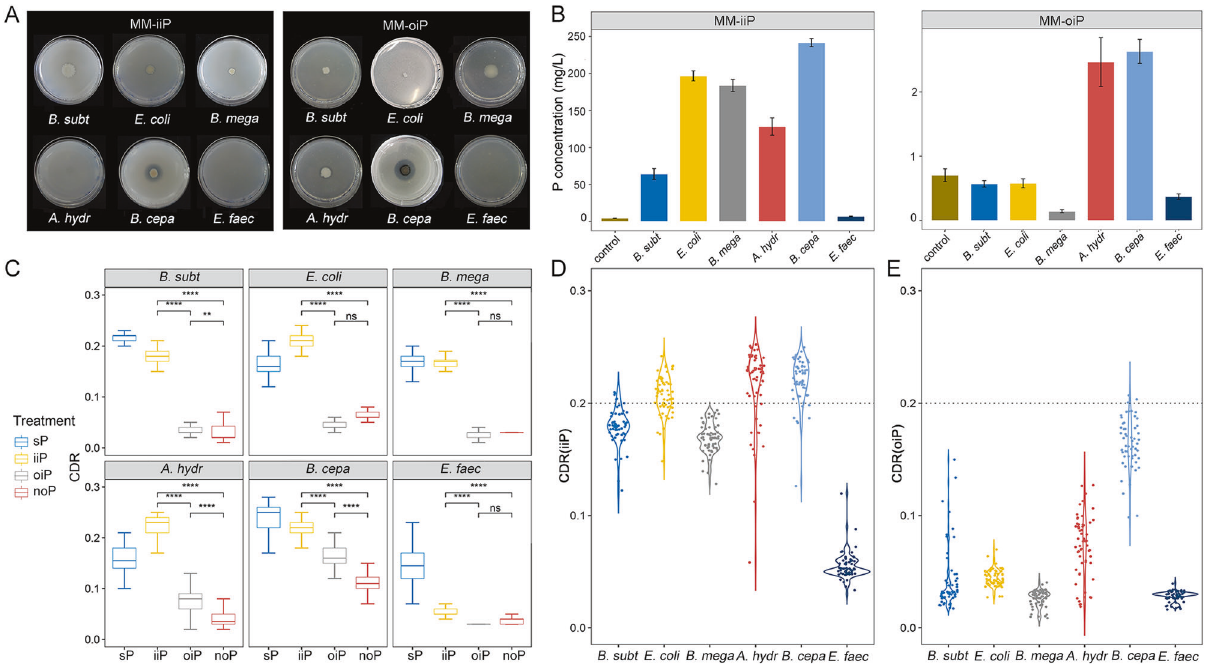
Fig. 2 Determination of phosphorus-releasing capacity of pure-cultured bacteria that include B. subtilis H6, E. coli BL21, B. megaterium ACCC02970, A. hydrophila ATCC7966, B. cepacian BN337012, and E. faecium PH07. A Halo zones produced by these strains on the solid medium of MM-iiP and MM-oiP, respectively; B Concentrations of soluble P in supernatant via the molybdenum-antimony resistance colorimetric method in the liquid medium of MM-iiP and MM-oiP, respectively. Error bars represent the standard deviation of three measurements from biological triplicates; C C-D ratios of the six bacteria strains incubated in minimum media containing 50%-D 2 O without P (P_free), with dissolvable P (sP), Ca 3 (PO 4 ) 2 (iiP) and lecithin (oiP), respectively. CDR distribution patterns of the six species are compared between MM-iiP ( D ) and MM-oiP ( E ). CDR = 0.20 was chosen as the threshold. Sixty individual cells from each bacteria sample were measured by Raman